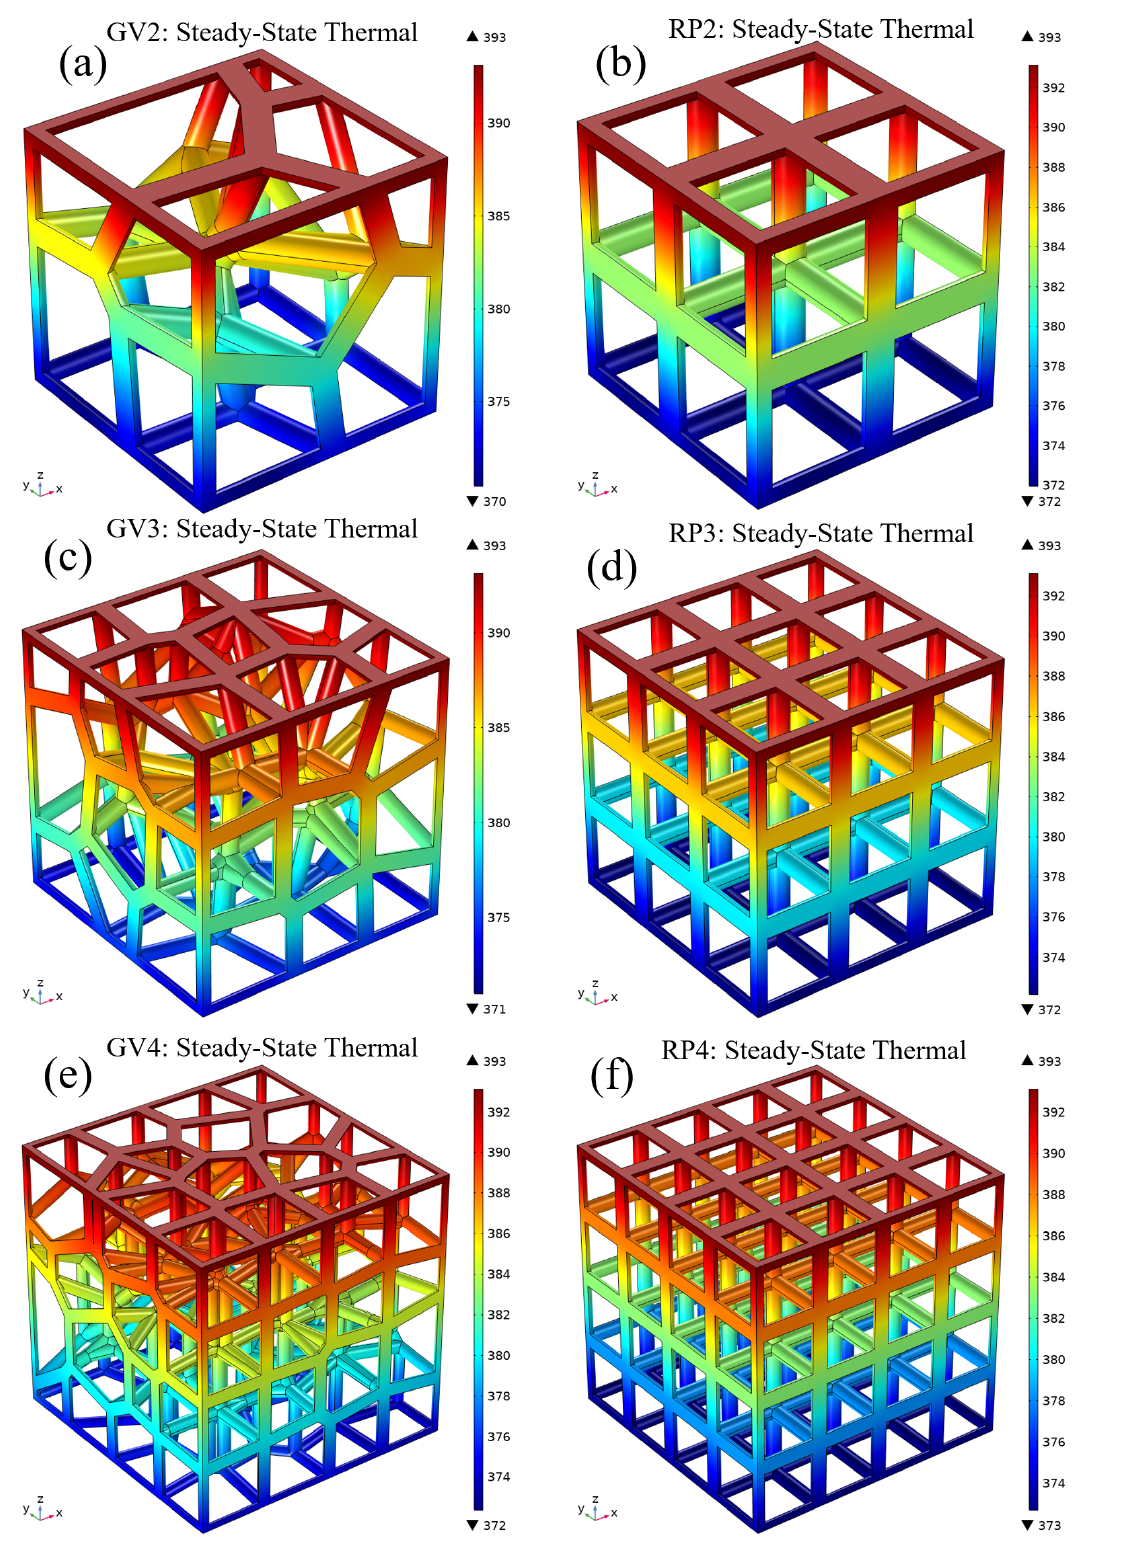
Figure 10. The steady-state temperature distributions for six structures with 89% porosity: ( a ) GV2; ( b ) GV3; ( c ) GV4; ( d ) RP2; ( e ) RP3 ( f )